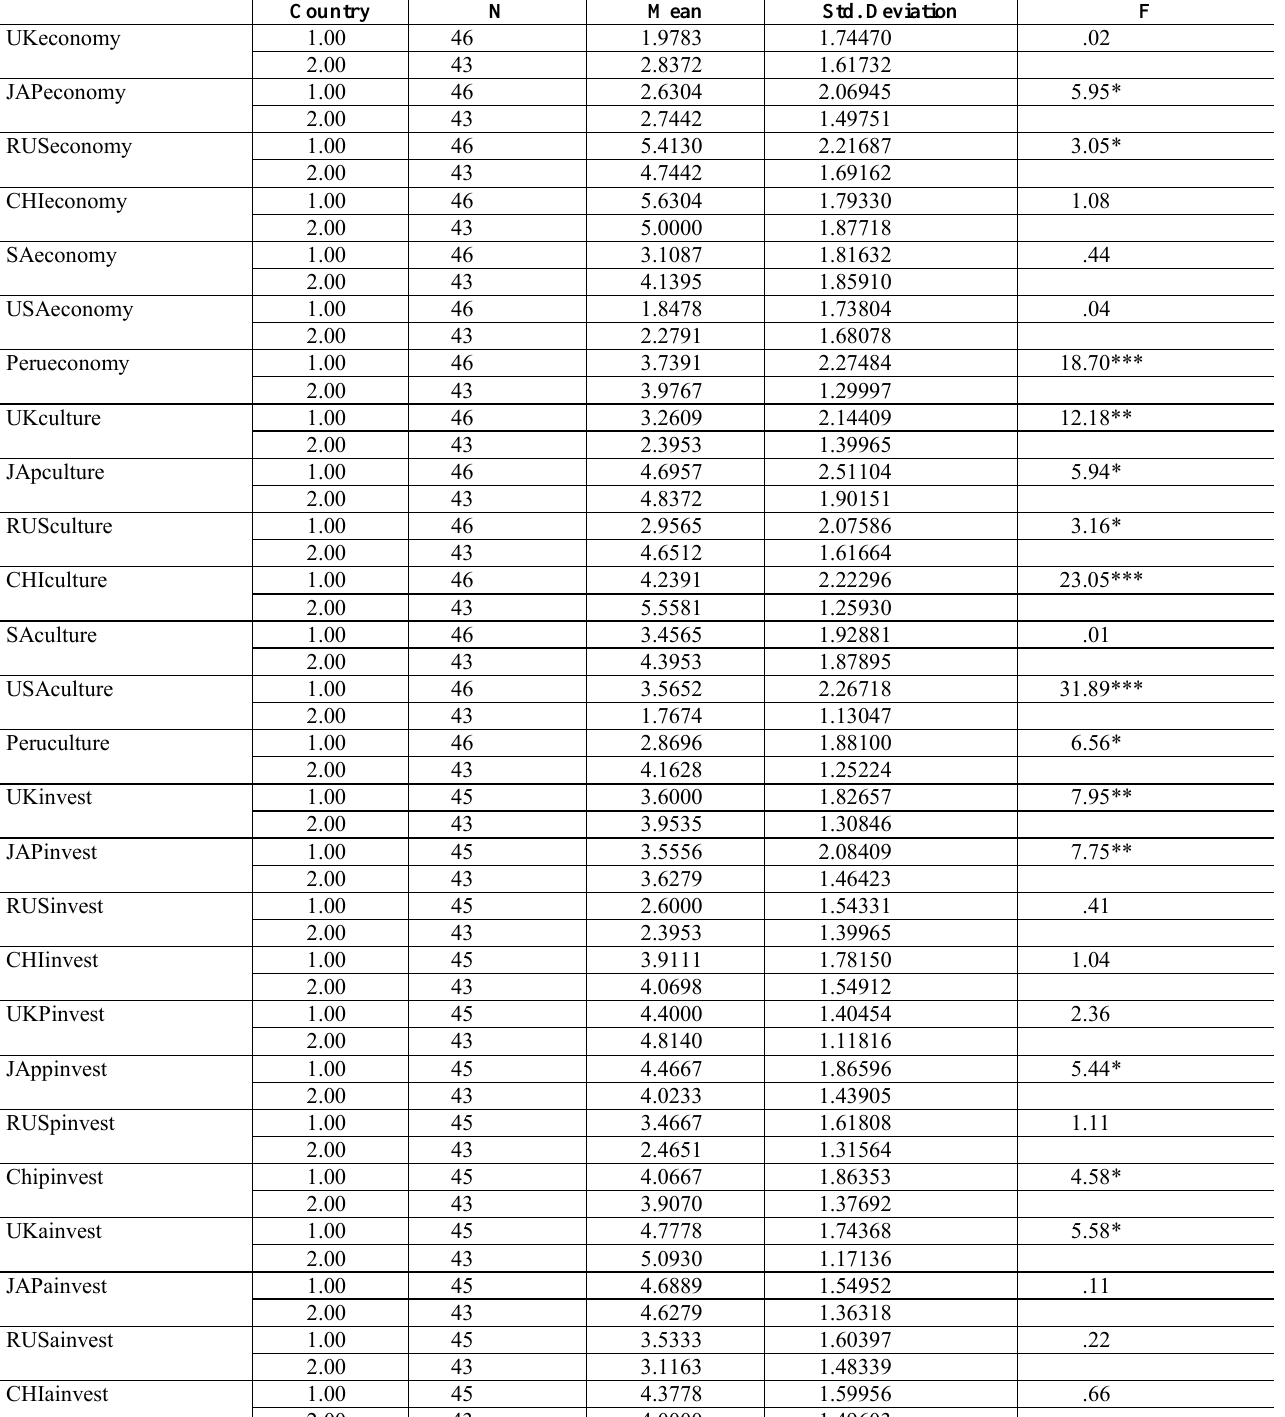
Table 4. T-Test group statistics (country 1 Saudi Arabia; Country 2 United States) Country N Mean Std. Deviation